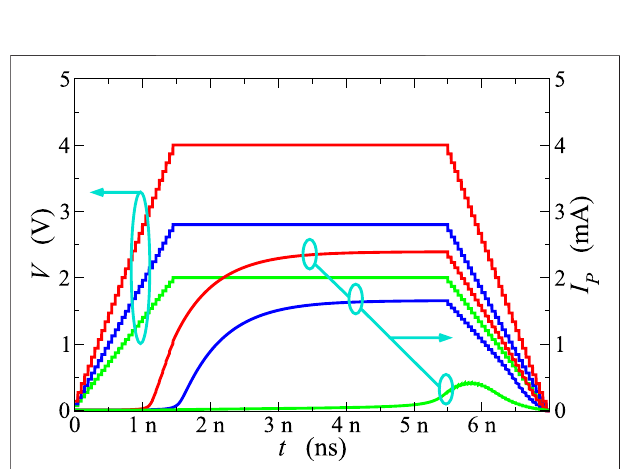
FIGURE 5 | Current fl owing across the PCM device as a function of time (right scale) after the application of voltage trapezoidal pro fi les of different amplitude(leftscale).Inallcases,riseandfalltimesare1.5 nsandtheduration of the plateau is 4